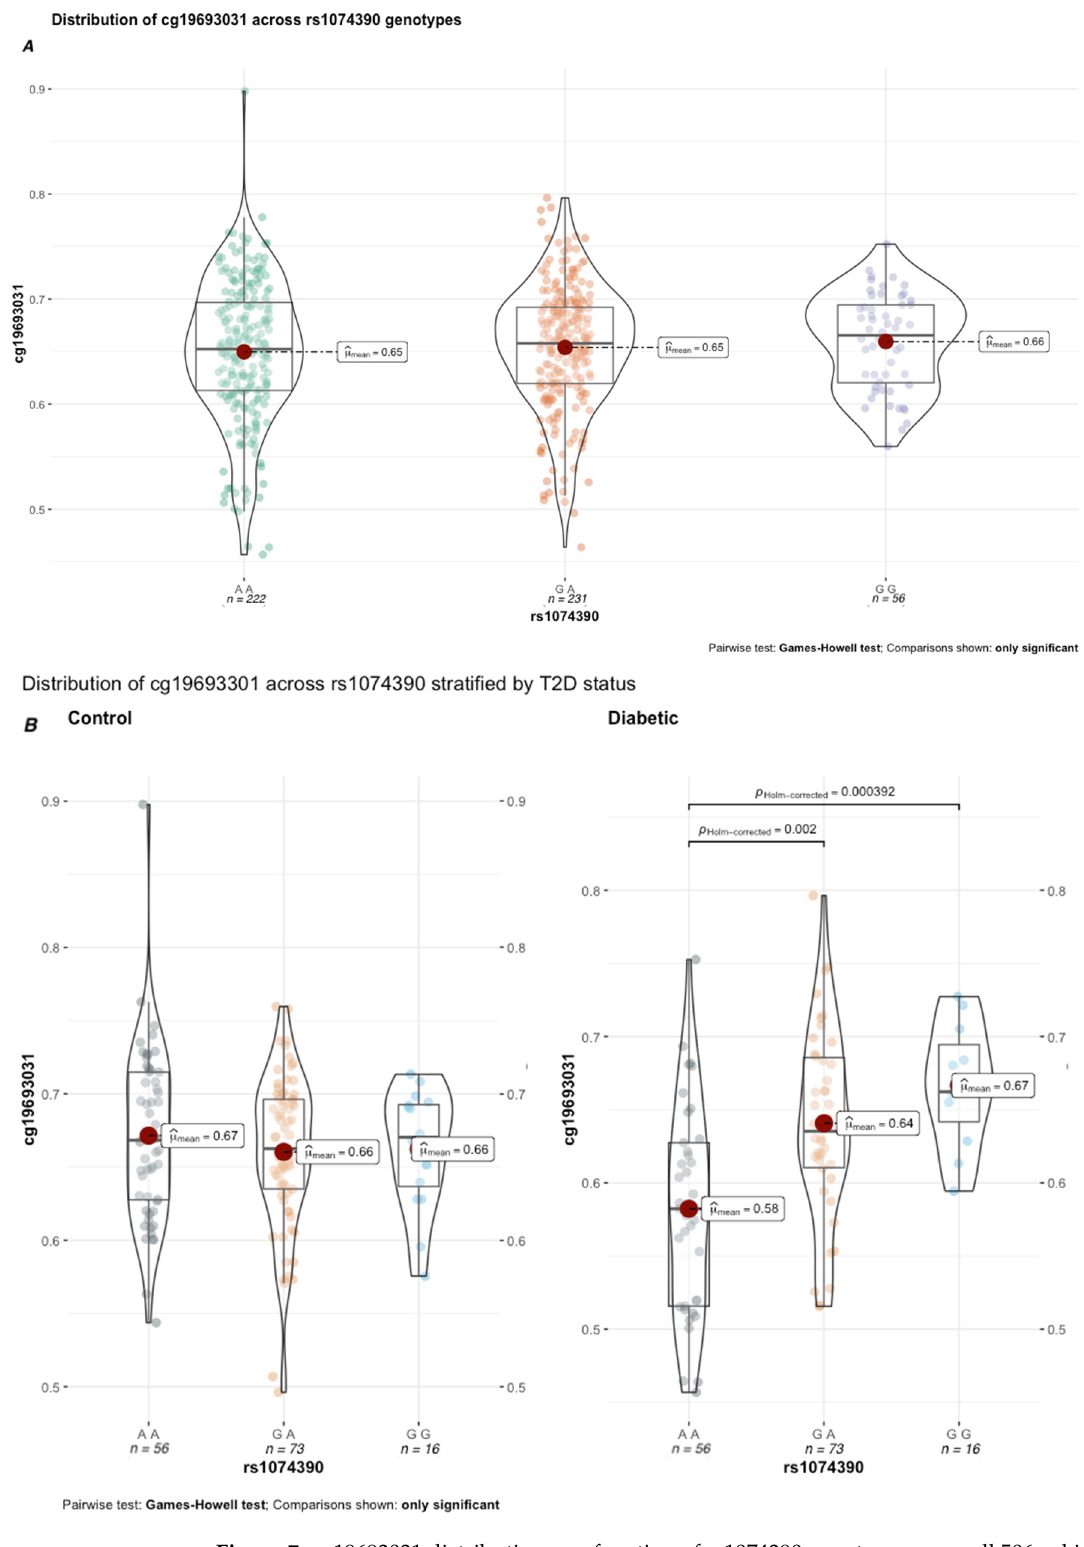
Figure 7. cg19693031 distribution as a function of rs1074390 genotype across all 506 subjects ( A ) and stratified by T2D status ( B ) .